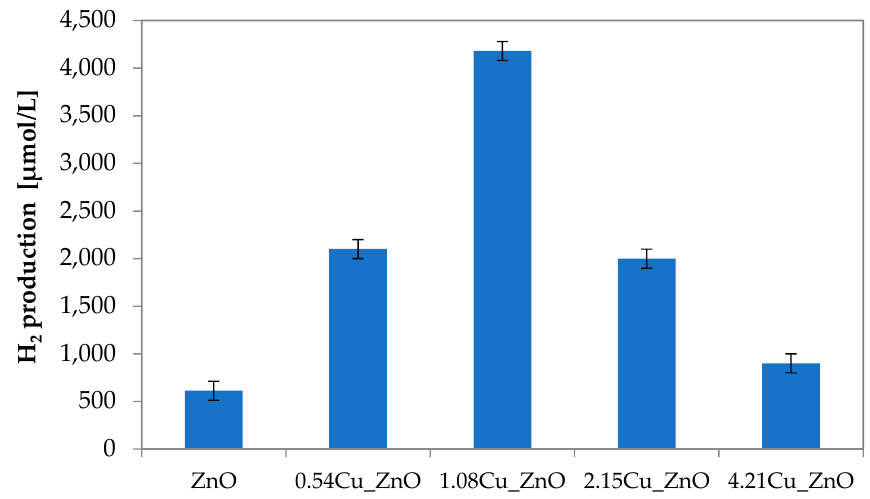
Figure 1. Influence of Cu content on hydrogen production under visible light after 4 h of visible irradiation time. Glycerol initial concentration: 5 wt %; catalyst dosage: 1.5 g / L; solution pH: 6; visible light intensity: 32 mW / cm 2 .